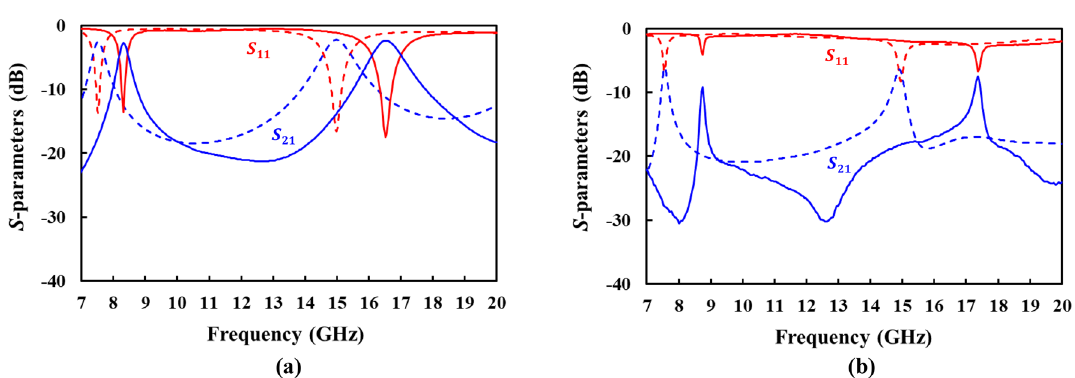
Figure 13. Measured (solid) and simulated (slotted) S -parameters of ( a ) microstrip and ( b ) DS SSPP ring resonators.